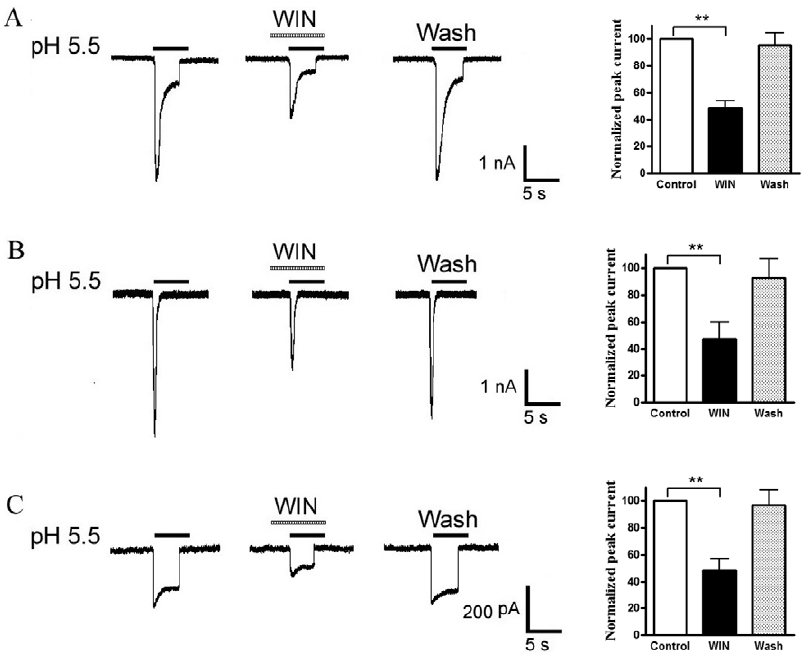
Figure 2. Inhibition of the three types of proton-gated currents by WIN55,212-2. Pre-application of WIN55,212-2 (WIN, 10 2 7 M) for 60-s decreased the peak phases of all three types of proton-induced currents (Original current traces in left). Bar graphs in right panel show currents normalized to control (100%, white column). Data in all bar graphs are shown relative to control. Error bars show 6 SEM. Statistical tests were performed on raw data using pairing t -test, and significance is shown as follows: *P , 0.05, **P , 0.01. n=6/each column.